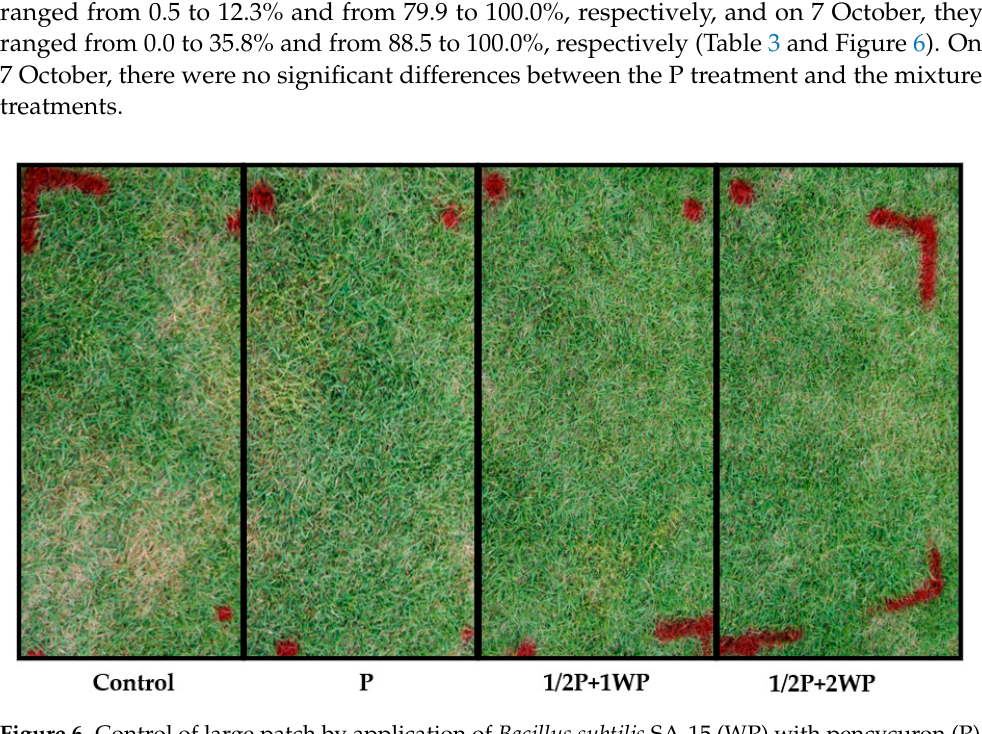
Figure 6. Control of large patch by application of Bacillus subtilis SA-15 (WP) with pencycuron (P). Treatments were as follows: control, no treatment; P, 1.0 mL ∙ m − 2 P; 1/2P + 1WP, 0.2 g ∙ m − 2 P + 1.0 g ∙ m − 2 WP; and 1/2P + 2WP, 0.2 g ∙ m − 2 P + 2.0 g ∙ m − 2 WP. Table 3. Diseased area and control efficiency of large patch in zoysiagrass after the application of various combinations of Bacillus subtilis SA-15 (WP) and pencycuron (P). Diseased Area Treatment 1